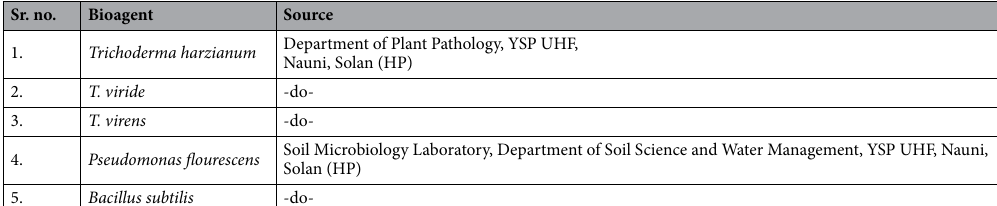
Table 3. Details of bioagents used in the